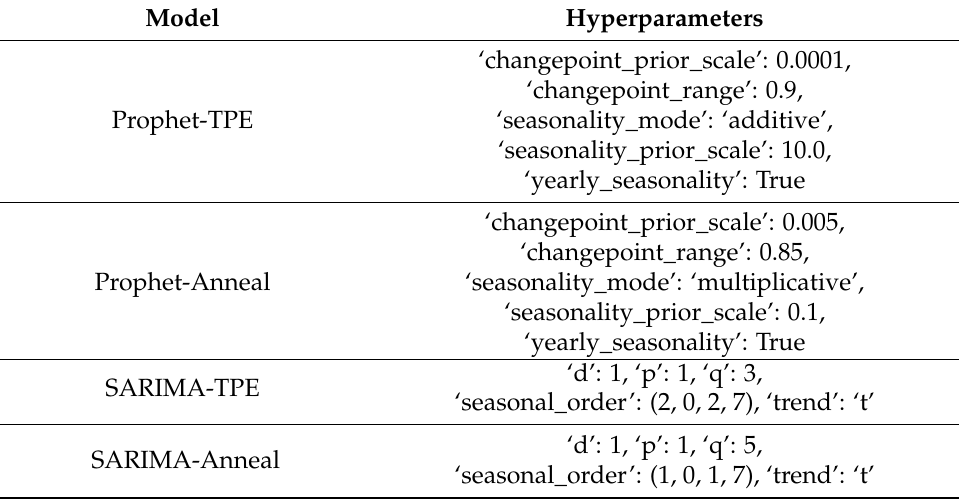
Table A2. Hyperparameter results for state-level NWOCI forecast showing the optimal hyperparam- eter values for each of the four Bayesian Prophet and SARIMA